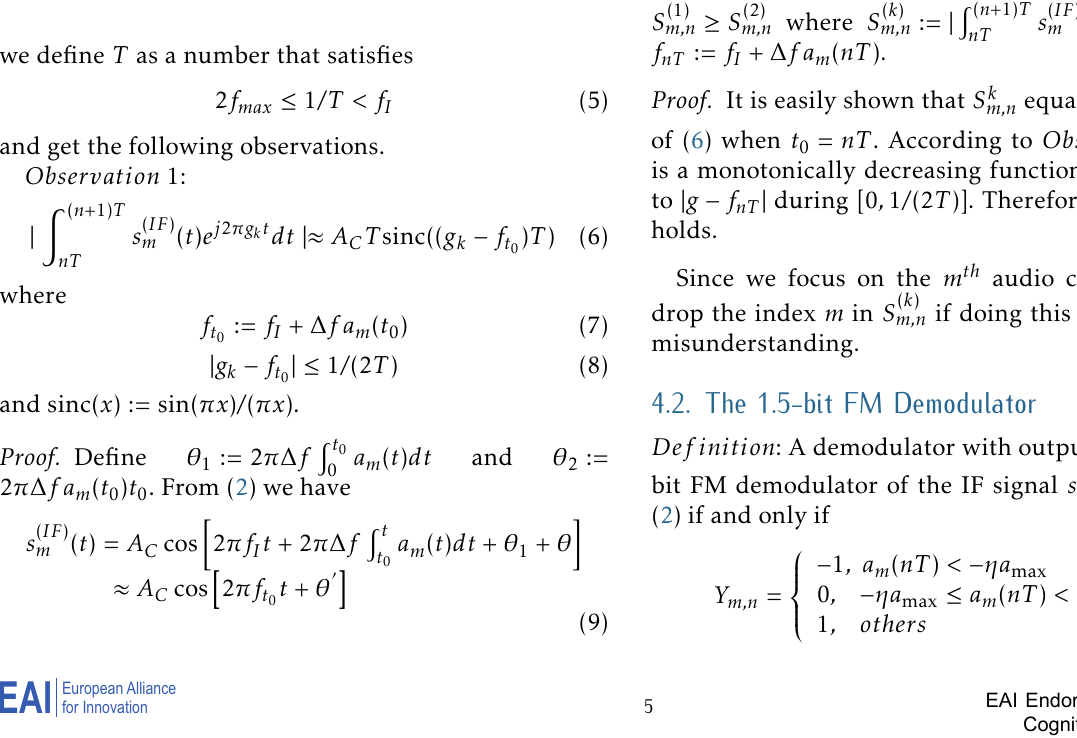
Figure 3. The relationship between a Y n of a 1.5-bit FM demodulator, where − η and η are two decision